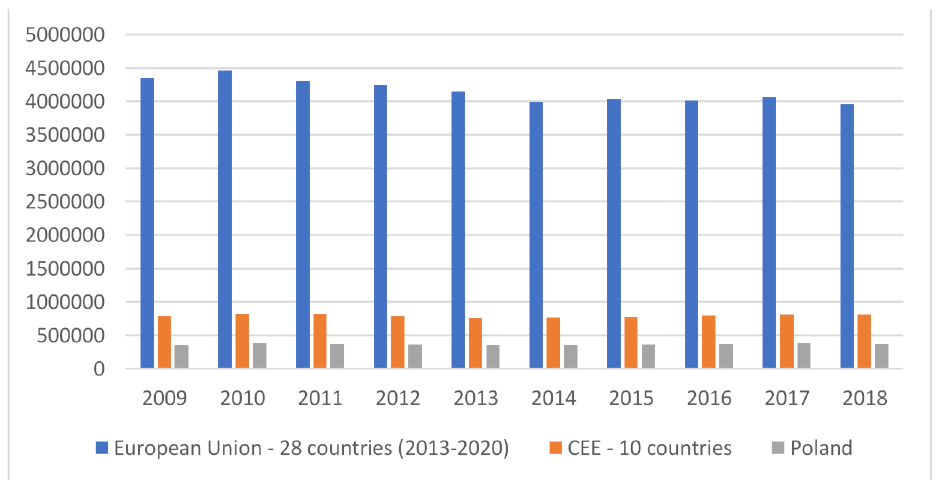
Figure 2. Greenhouse gases—total (CO 2 , N 2 O in CO 2 equivalent, CH4 in CO 2 equivalent, HFC in CO 2 equivalent, PFC in CO 2 equivalent, SF6 in CO 2 equivalent, NF3 in CO 2 equivalent) (thousand tonnes of CO 2 ). Source: Own calculations based on Eurostat database